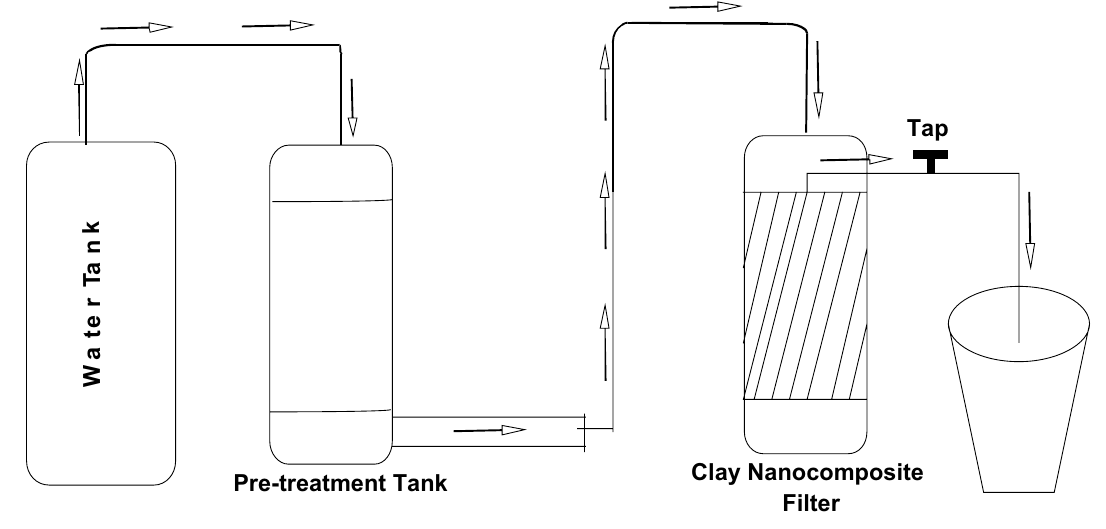
Fig. 21 The large-scale nanocomposite filtration